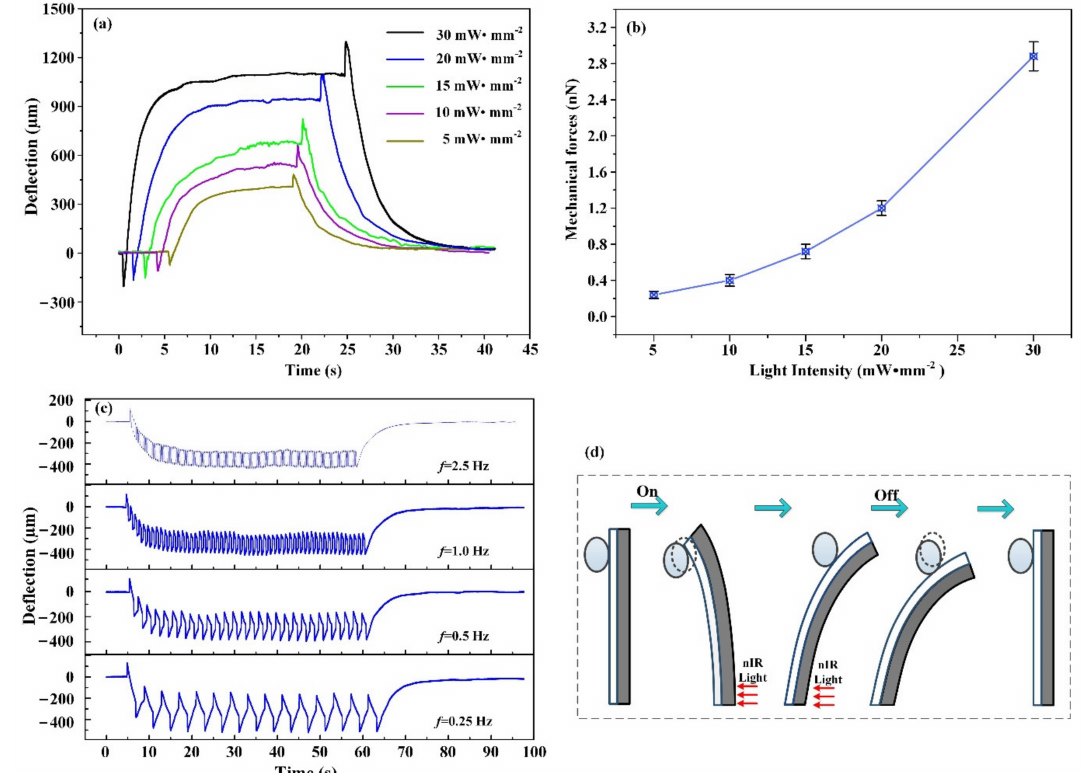
Figure 5. Mechanical force loading was controlled and adjusted. ( a ) Photomechanical bending was controlled by nIR light intensities ranging from 5 to 30 mW · mm − 2 for a bilayer containing 4 wt% MNPs. ( b ) Theoretical mechanical forces controlled by light intensities. ( c ) nIR light frequencies adjusted photomechanical bending when nIR light intensity was 15 mW · mm − 2 . ( d ) PS microsphere oscillation under nIR light mimics the cell actuated by photomechanical